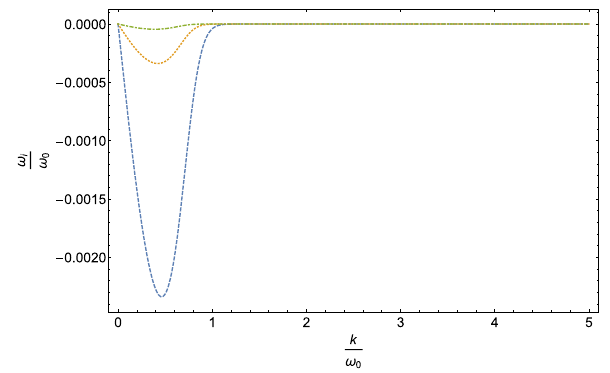
Fig. 2 Normalizeddampingcoefficient ¯ ω i vsnormalizedwavenumber ¯ k fordifferentvaluesoftheparameter x : x = 30 (dashedcurve), x = 40 (dotted curve), x = 50 (dot-dashed